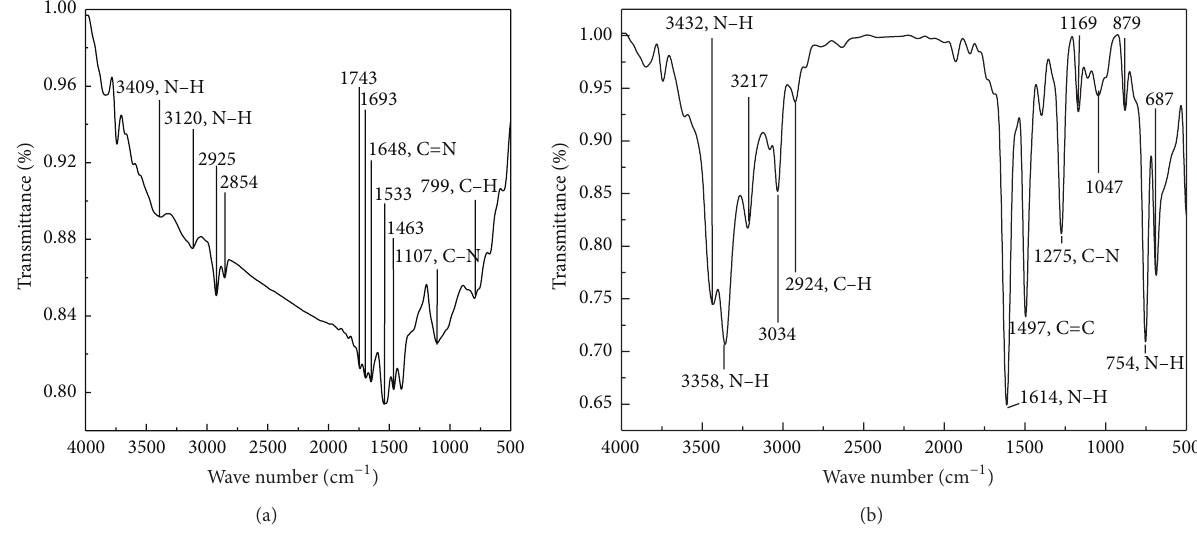
Figure 1: FTIR spectra of PANI (a) and aniline